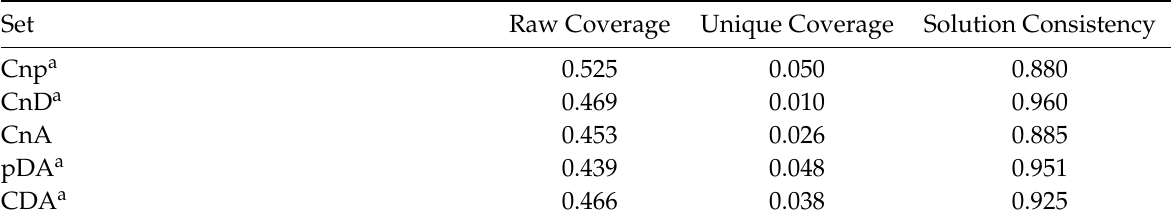
Table 6: Final configurations and coverage statistics of fsQCA